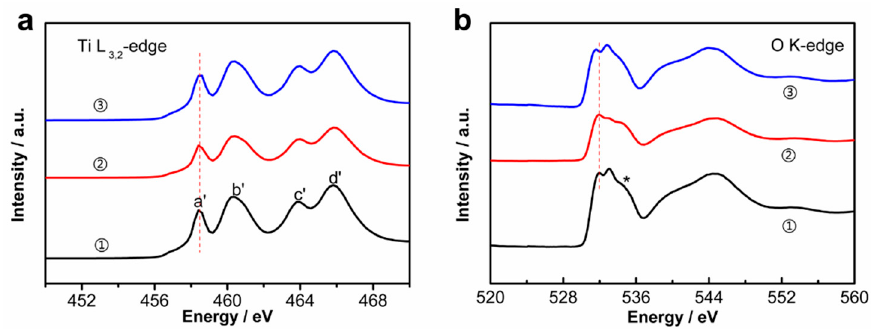
Figure 5. XANES spectra of ( a ) Ti L 3,2 -edge : the K 2 Ti 8 O 17 electrode ① without testing, ② charged to 250 mAh, and ③ discharged after charging to 250 mAh; and ( b ) O K-edge of the pristine and undergoing various charge–discharge reactions of K 2 Ti 8 O 17 electrode at the situations : ① without testing, ② charged to 250 mAh, and ③ discharged after charging to 250 mAh.